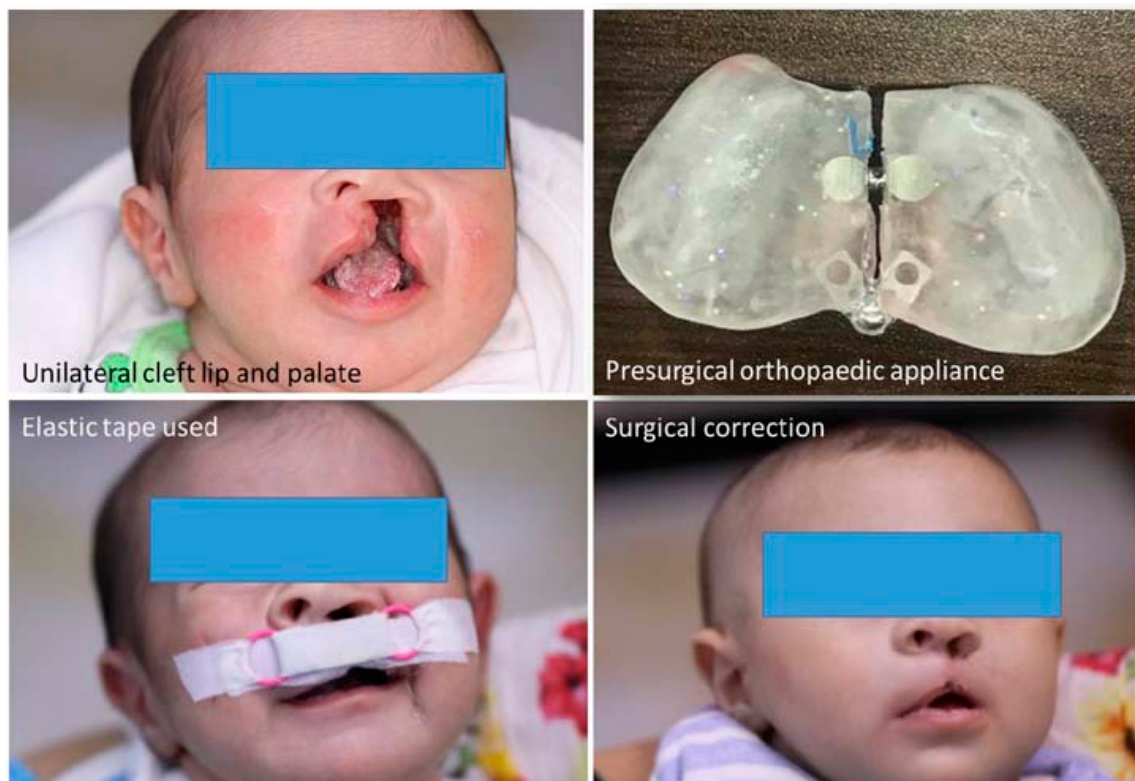
Figure 1. PSIO protocol in a CLP child and surgical treatment outcome.